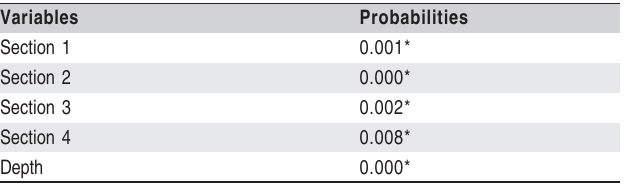
Table 2 - Comparison of groups A1 and B1.